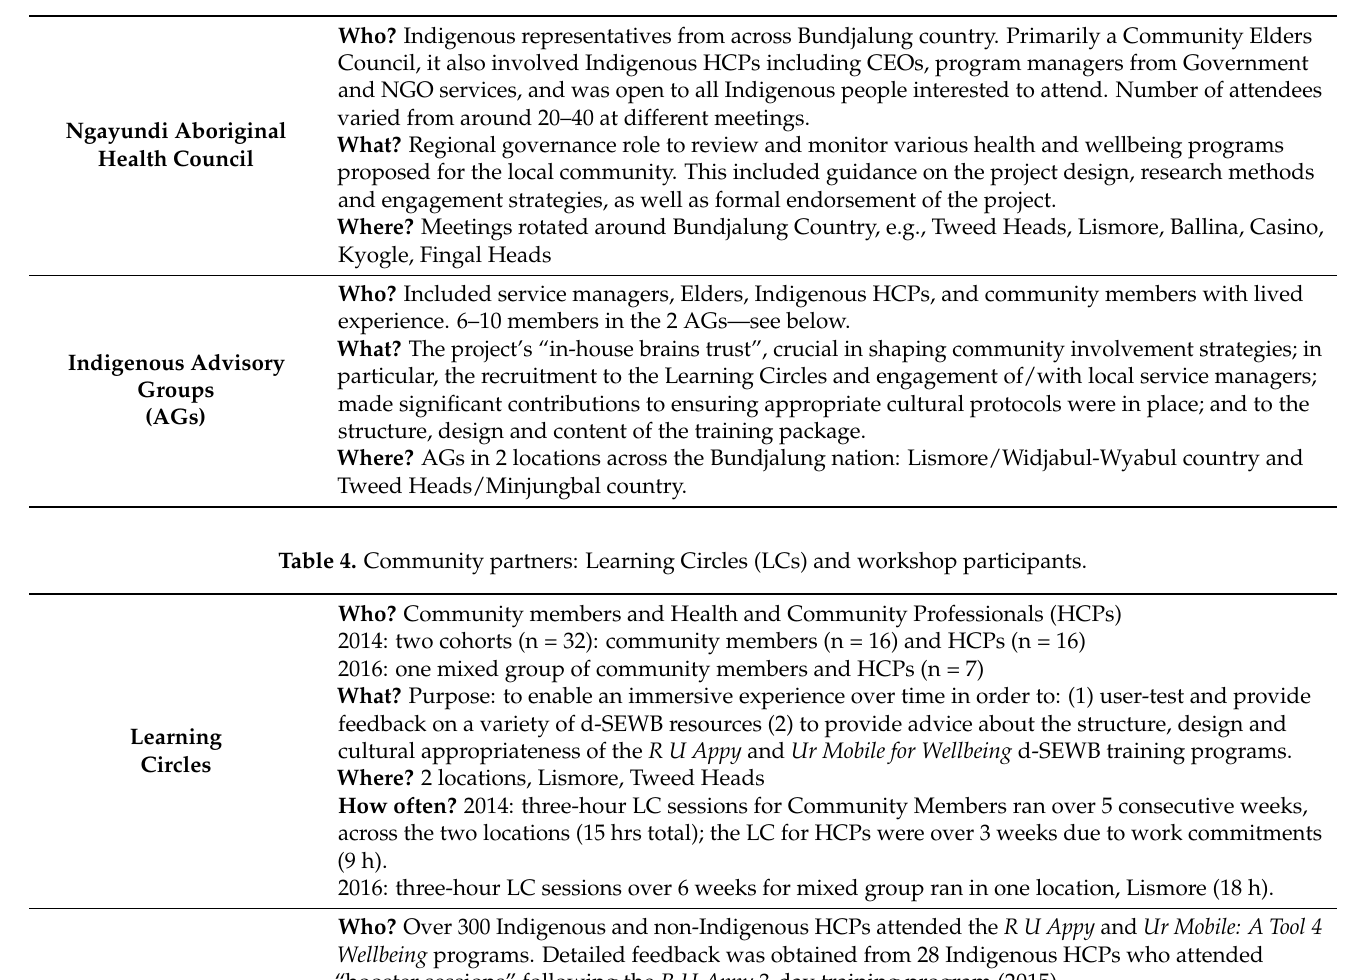
Table 3. Community partners: governance groups.